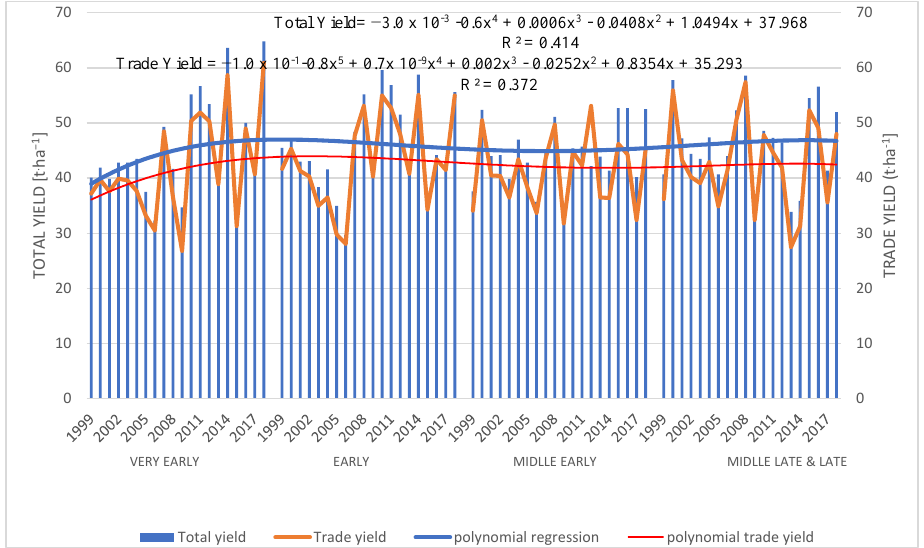
Total Yield= −3.0 x 10 -3 -0.6x 4 + 0.0006x 3 - 0.0408x 2 + 1.0494x + 37.968 R² = 0.414 Trade Yield = −1.0 x 10 -1 -0.8x 5 + 0.7x 10 -9 x 4 + 0.002x 3 - 0.0252x 2 + 0.8354x + 35.293 R² = 0.372